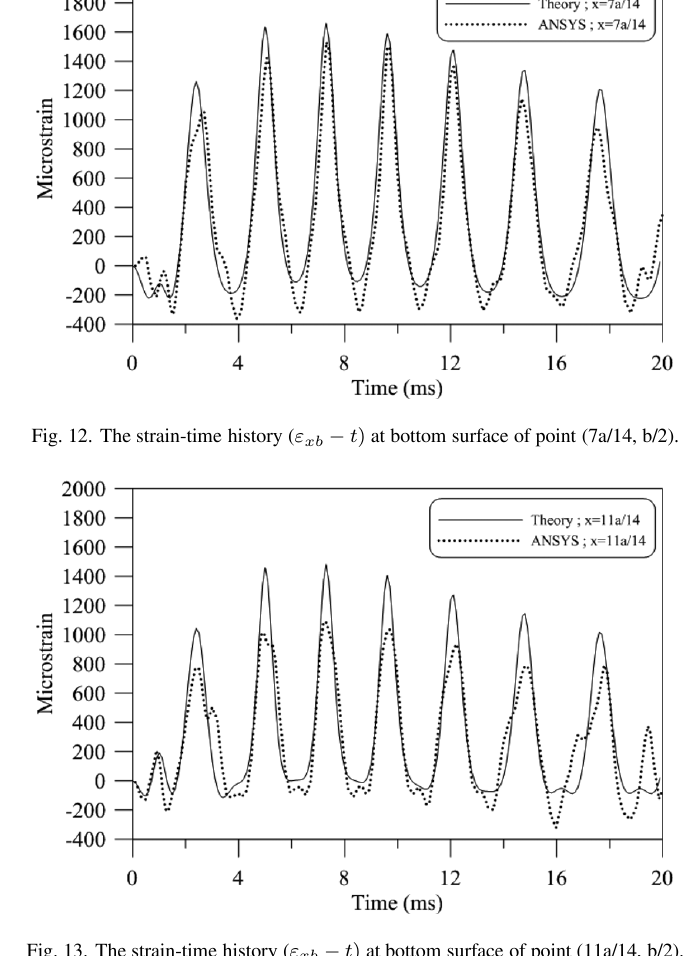
Fig. 13. The strain-time history ( ε xb − t ) at bottom surface of point (11a/14, b/2).